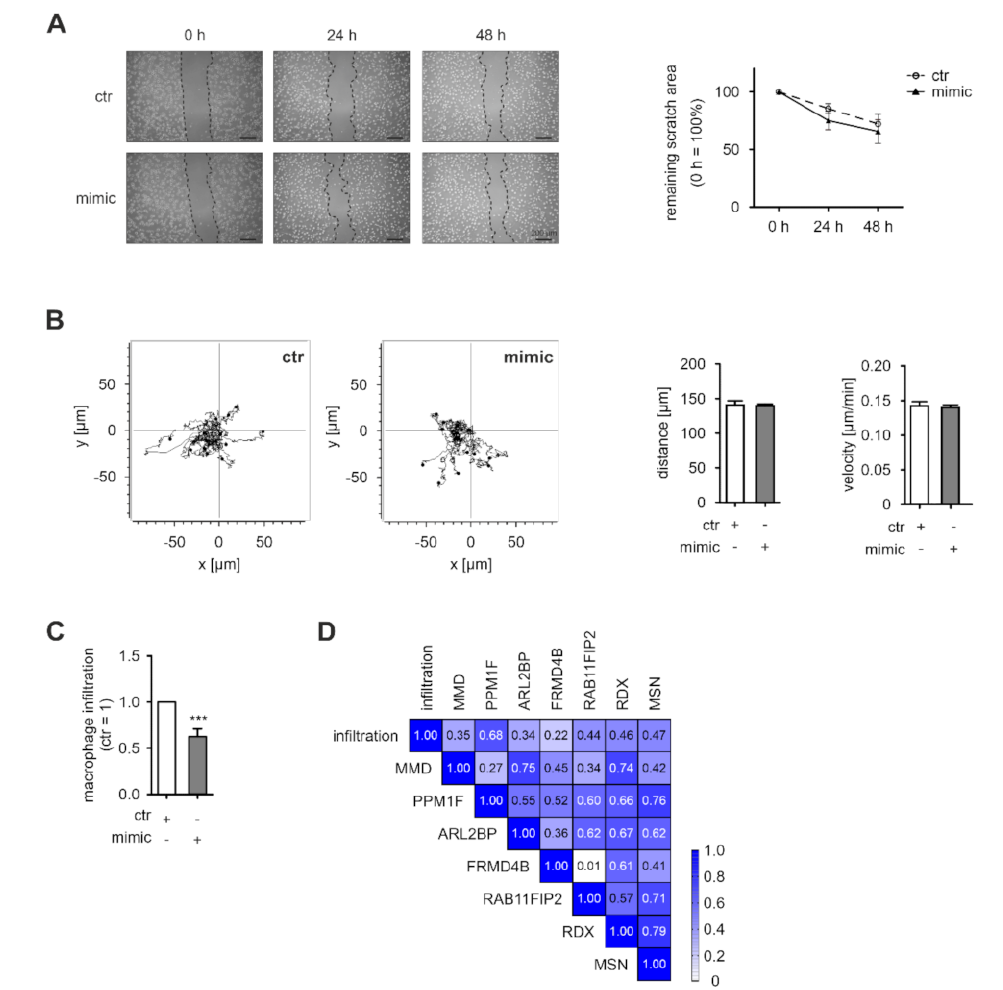
Figure 4. miR-200c overexpression in M Φ alters spheroid infiltration. Primary human macrophages (M Φ ) were transfected with miR-200c mimic (mimic) or mimic control (ctr). ( A ) Twenty-four hours after transfection, a scratch was generated and scratch closure was evaluated after 24 and 48 h by microscopy (representative pictures shown in the left panel ). Quantitative assessment of the remaining scratch area was carried out using ImageJ ( n = 6; right panel ). ( B ) Forty-eight hours after transfection, M Φ were seeded on fibronectin-coated ibiTreat µ -slides. M Φ migration was determined by live cell tracking for 16 h and quantified using the tracking application of the AxioVisionSoftware. Fifteen representative tracks are depicted ( left panel ) and a total of 50 cells per condition were analyzed per replicate regarding distance and velocity ( n = 4, right panel ). ( C ) Forty-eight hours after transfection, M Φ were transferred onto 4-day-old MCF7 tumor spheroids and allowed to infiltrate for 24 h prior to flow cytometric analysis. Infiltration of mimic-transfected M Φ into spheroids was normalized to ctr-transfected M Φ . Infiltration was determined as number of CD45+ cells in single cell suspensions of infiltrated tumor spheroids. Data are presented as mean ± SEM ( n = 13; *** p < 0.001). ( D ) Correlation of tumor spheroid infiltration with the expression of potential miR-200c targets of the migration-associated miR-200c signature including MMD (monocyte to macrophage differentiation- associated 1), PPM1F (protein phosphatase 1F), ARL2BP (ADP-ribosylation factor-like protein 2 binding protein), FRMD4B (FERM domain-containing 4B), RAB11FIP2 (RAB11 family-interacting protein 2), RDX (radixin), and MSN (moesin). mRNA expression in M Φ was determined at the beginning of the